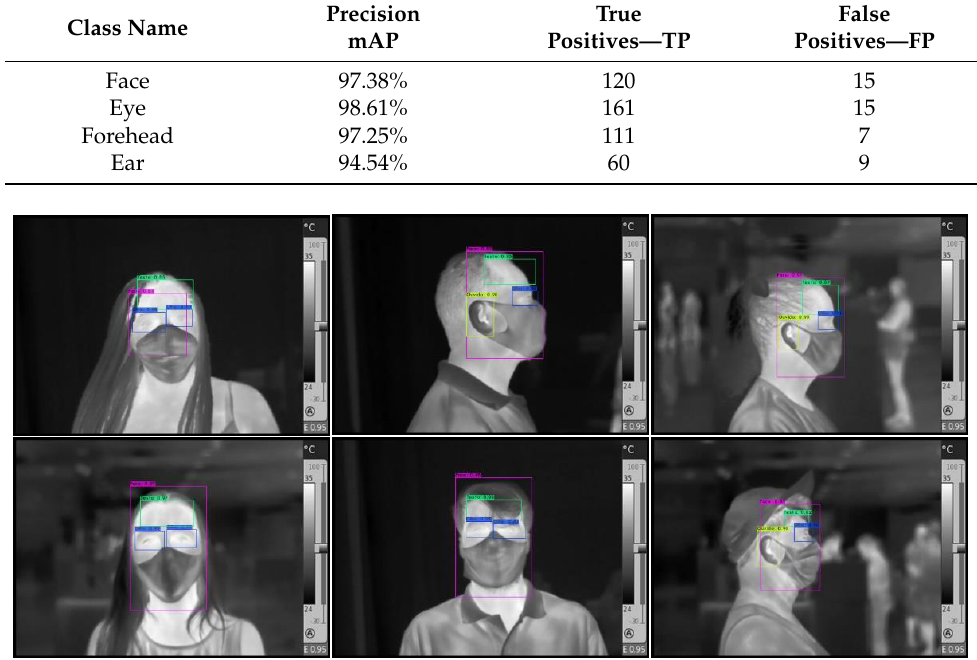
Figure 7. Images produced using the Testo-885 camera and analyzed by YOLO.